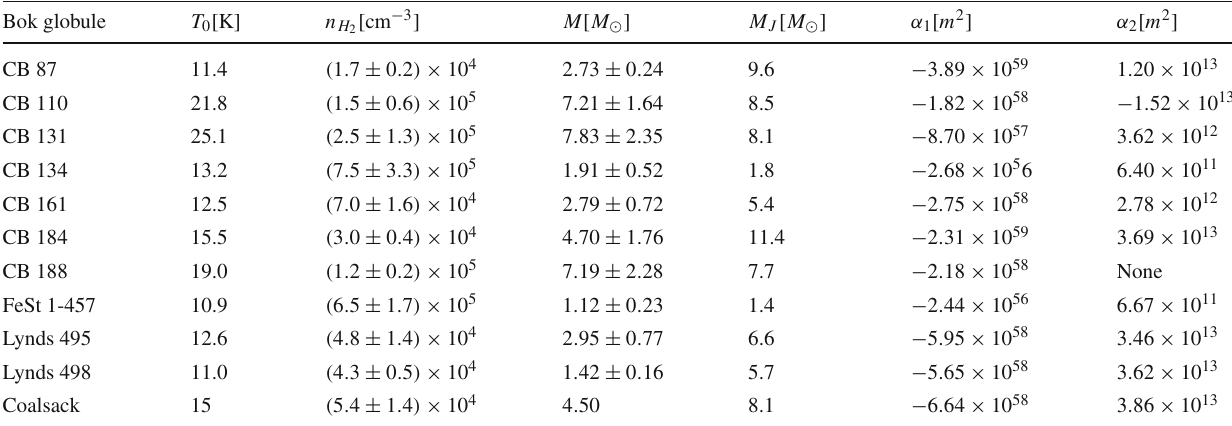
Table2 Kinetictemperature,particlenumberdensity,mass,Jeans’massandobservedstabilityfromseveralBokglobules[69,70],andthesaturation bounds found for α in f(R) theories Bok